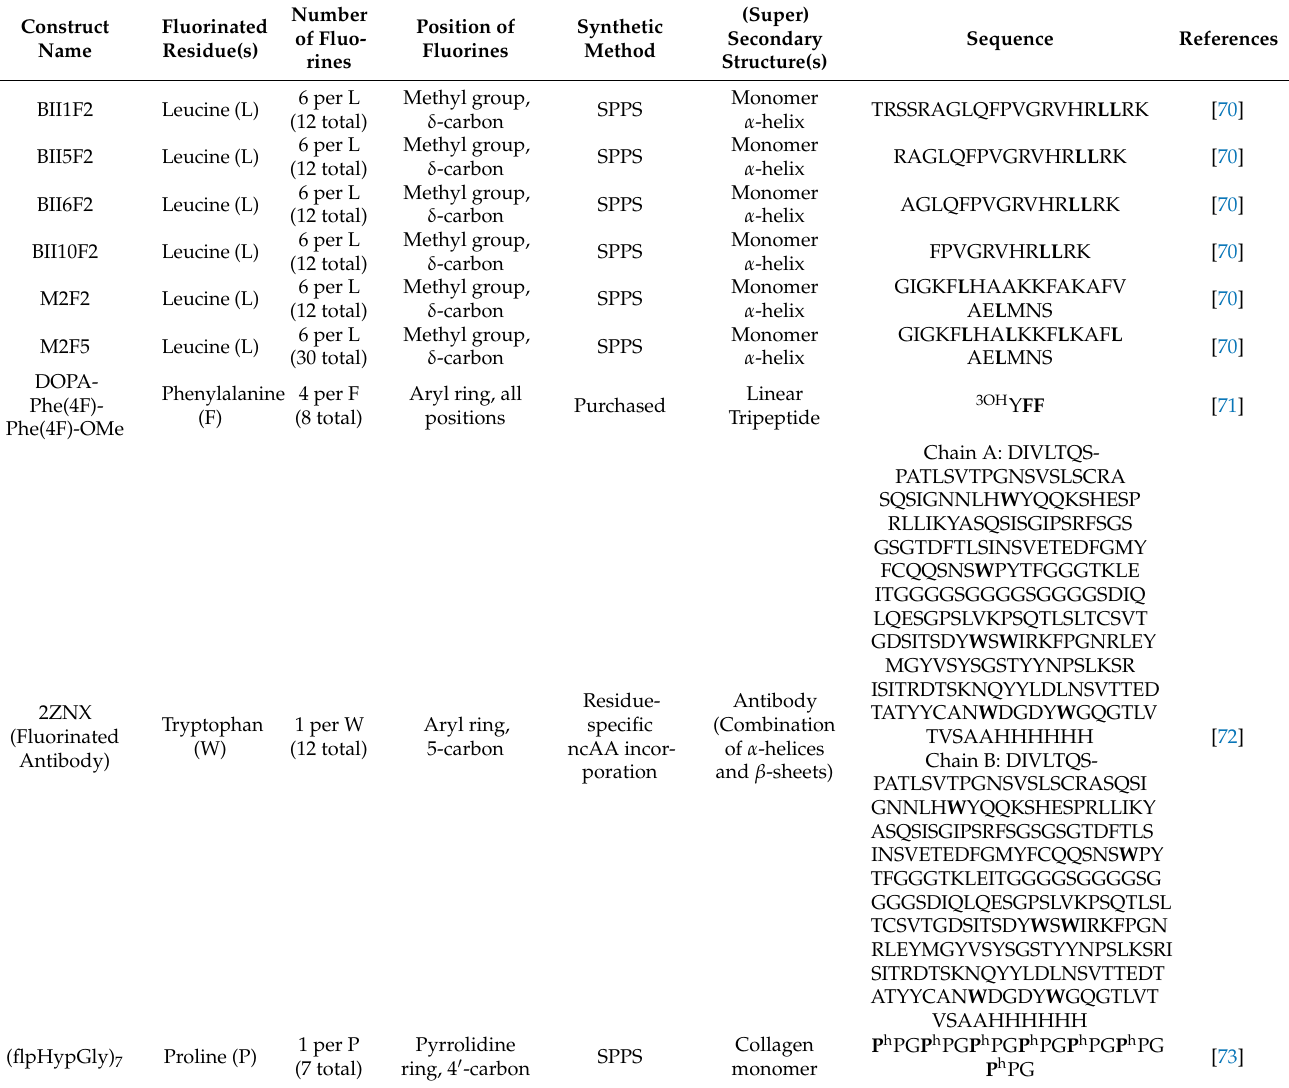
Table 3. Summary of fluorinated proteins and peptides constructs alongside their accompanying one letter AA sequences in the order they are discussed for their application as active therapeutic